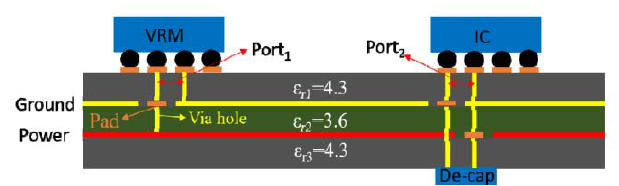
Figure 1: Tx-Rx circuit implemented on multilayer interconnect PCB [30-31].